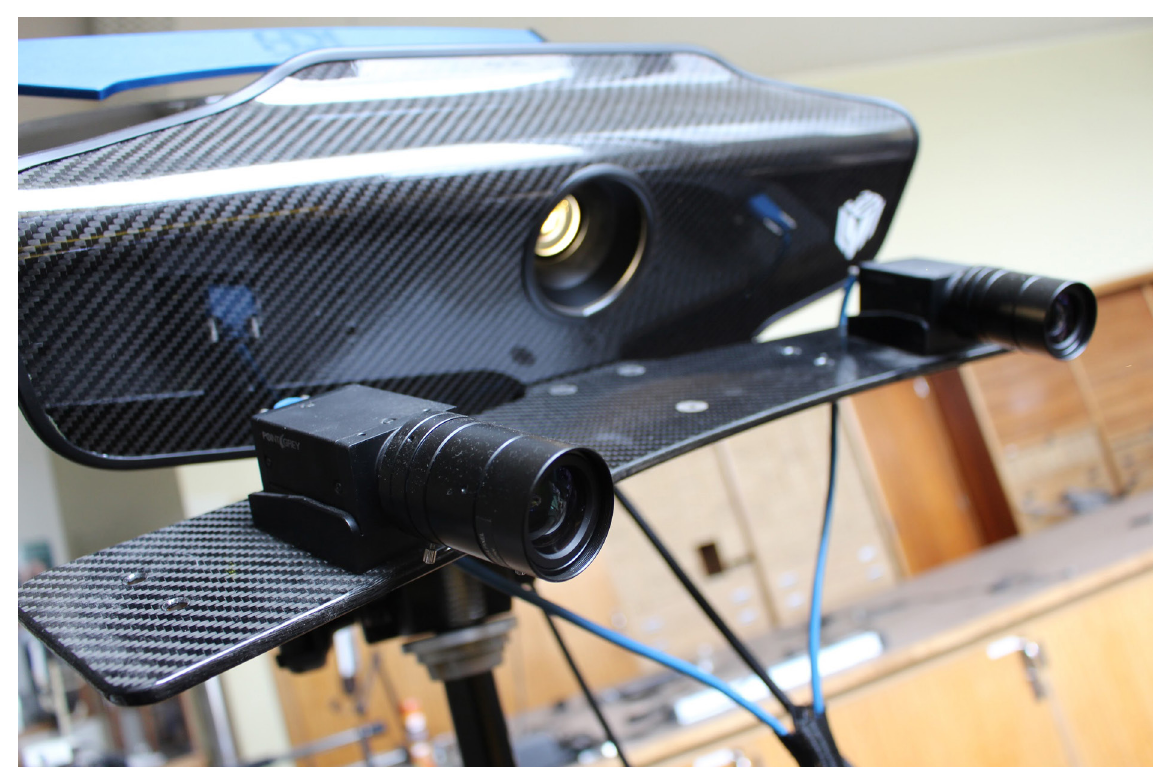
Fig. 3.23. The HDI white light